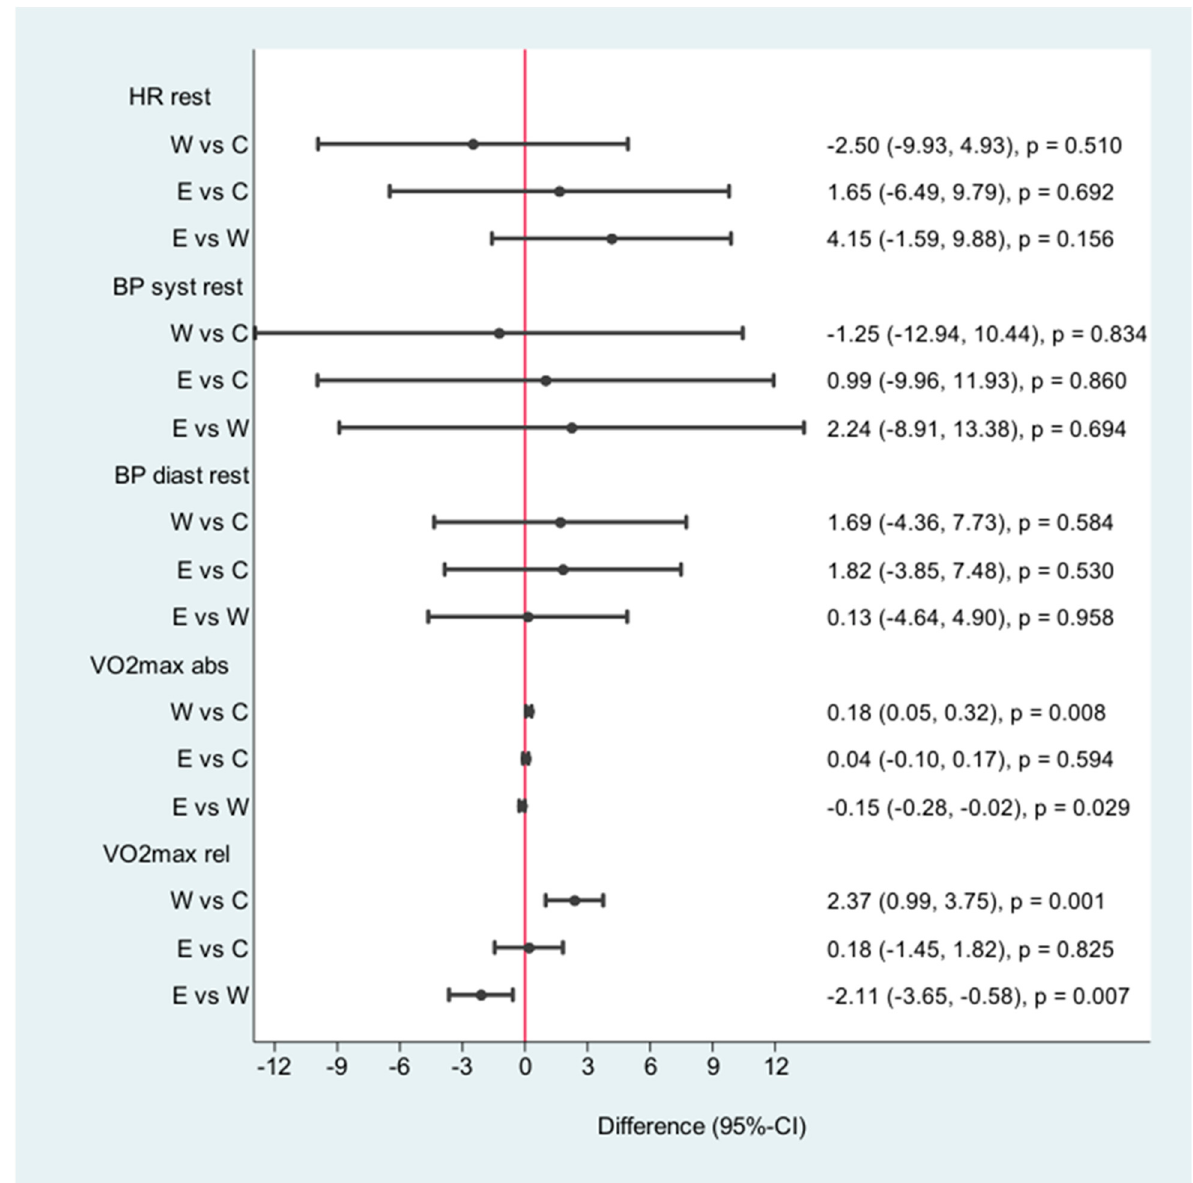
Figure 3. Differences after the intervention; HR = heart rate, BP = blood pressure, VO2 max abs = oxygen uptake max, VO2 max rel = oxygen uptake in relation to weight. W = walking, C = control, E = E-health (pedometer).